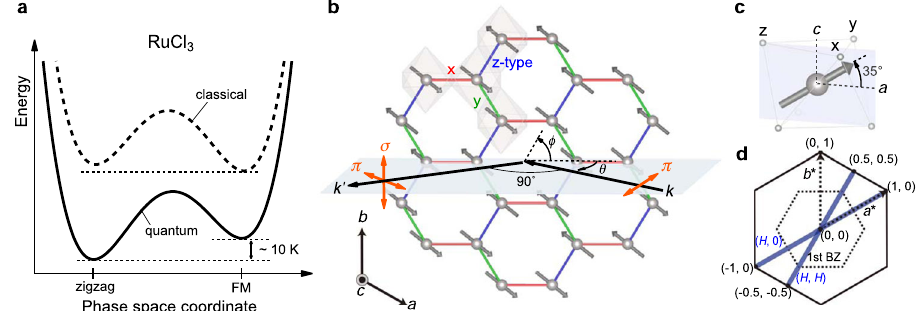
Fig. 1 Phase competition in RuCl 3 revealed by Ru L 3 edge RIXS, and the scattering geometry. a Schematic of classical and quantum energy landscapes in the vicinity of the zigzag ground state. The zigzag order is stabilized by quantum effects, and only slightly lower in energy than the competing metastable ferromagnetic (FM) state. b The pseudospin-1/2 moments (gray arrows) show the zigzag-type magnetic order pattern on the honeycomb lattice of α - RuCl 3 . The gray-shaded RuCl 6 octahedra share the edges on the three distinct x , y , and z -type bonds, represented by the red, green, and blue lines, respectively. a , b , and c represent the crystallographic lattice vectors. The incident x-ray photons with momentum k are linearly π -polarized and the polarization of the scattered photons with momentum k 0 is not analyzed. The scattering angle is fi xed at 90 ∘ and the in-plane momentum transfer q is changed by rotating the sample angle θ . The azimuthal angle ϕ is used to change the measurement path. c Local moment direction in the RuCl 6 octahedron. The directions from the central Ru atom to the adjacent Cl atoms denoted by x , y , and z de fi ne the local x , y , and z coordinate axes. The magnetic moment lies within the ac plane and points 35 ∘ from the a axis 68,53 . d q = ( H , 0) and ( H , H ) paths investigated in the RIXS experiment. The dotted hexagon indicates the fi rst Brillouin zone